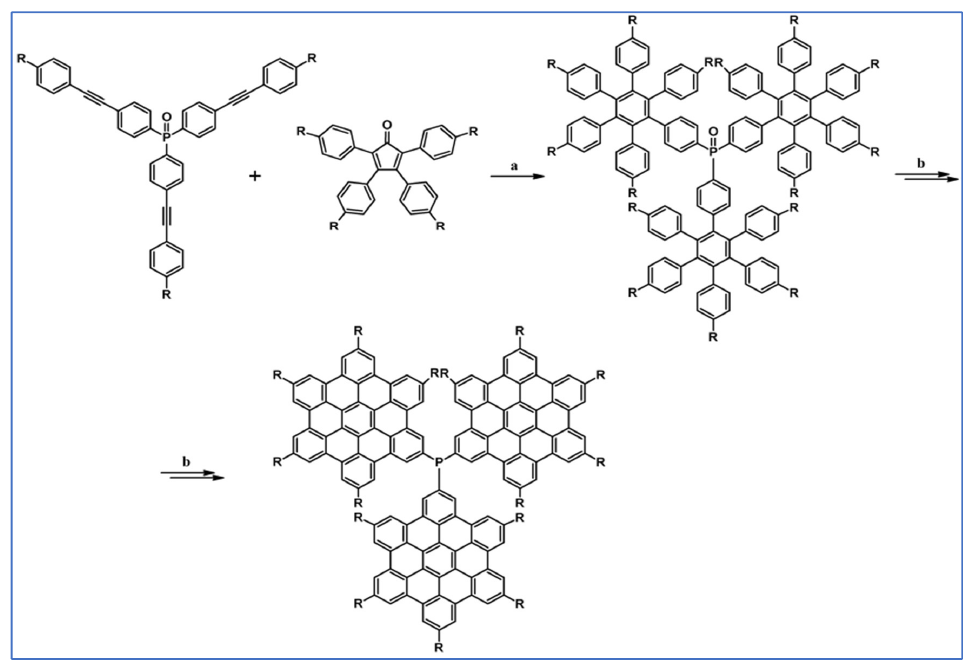
Scheme 206. Superphenylphosphines synthesis: Diels–Alder cycloaddition (tetrarylcyclopentadi- enone as a diene), Scholl dehydrocondensation, reduction of P=O bond—an example [256]. Reagents and conditions: R = t -Bu; a = Ph 2 O, 250 °C, Y = 92%; b = next steps (Scholl dehydrocondensation).